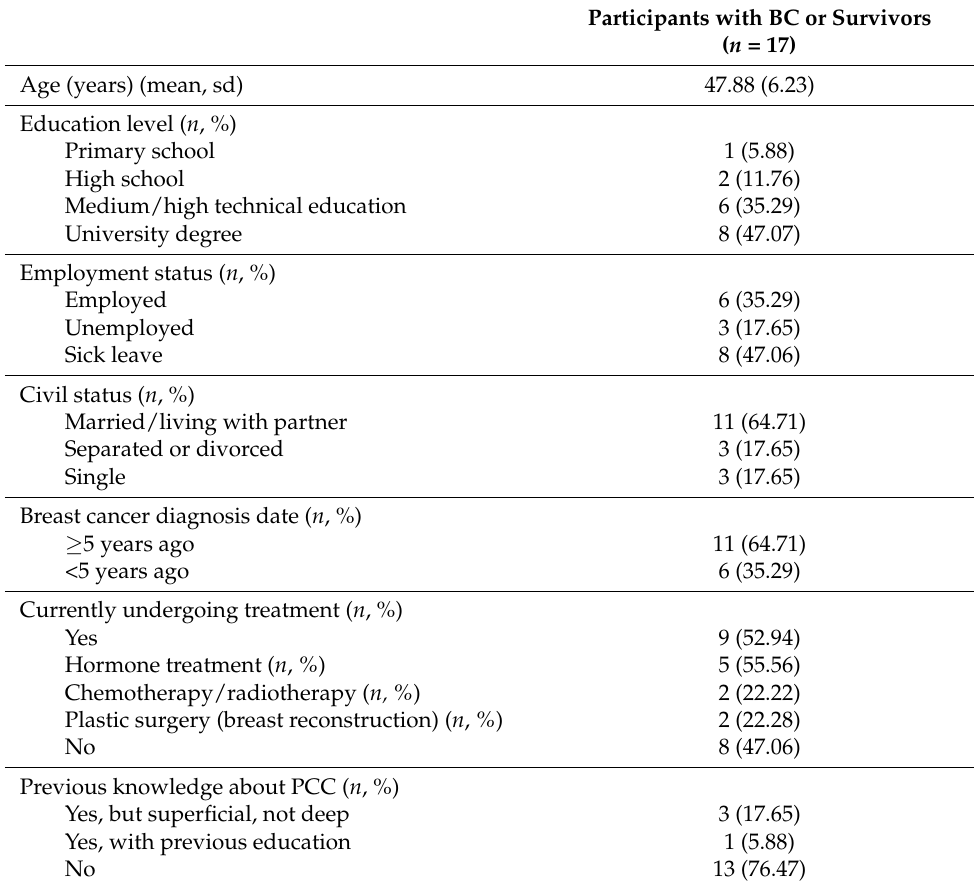
Table 1. Characteristics of the participants